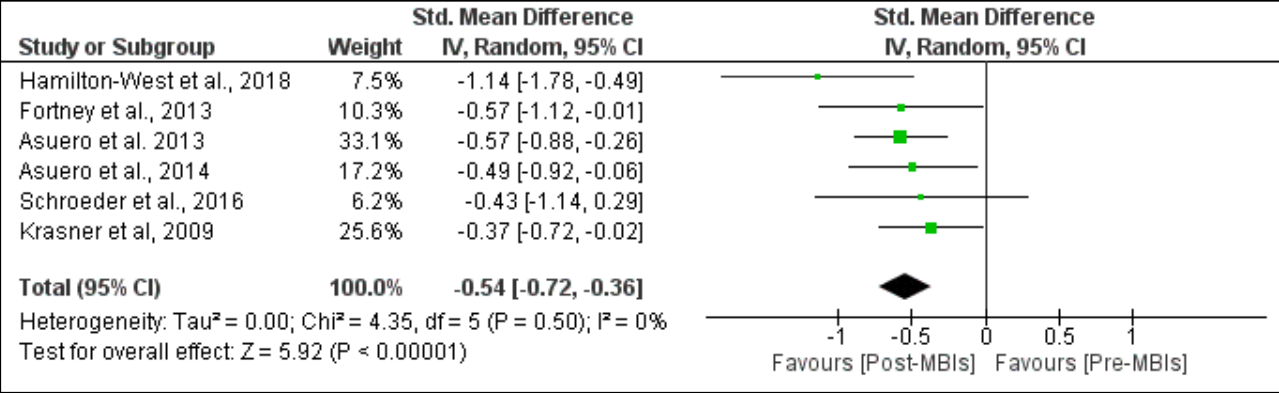
Figure 2. Effect of mindfulness-based interventions (MBIs) on emotional exhaustion in primary healthcare professionals. Results are reported as standardized mean difference and 95% confidence interval (CI).